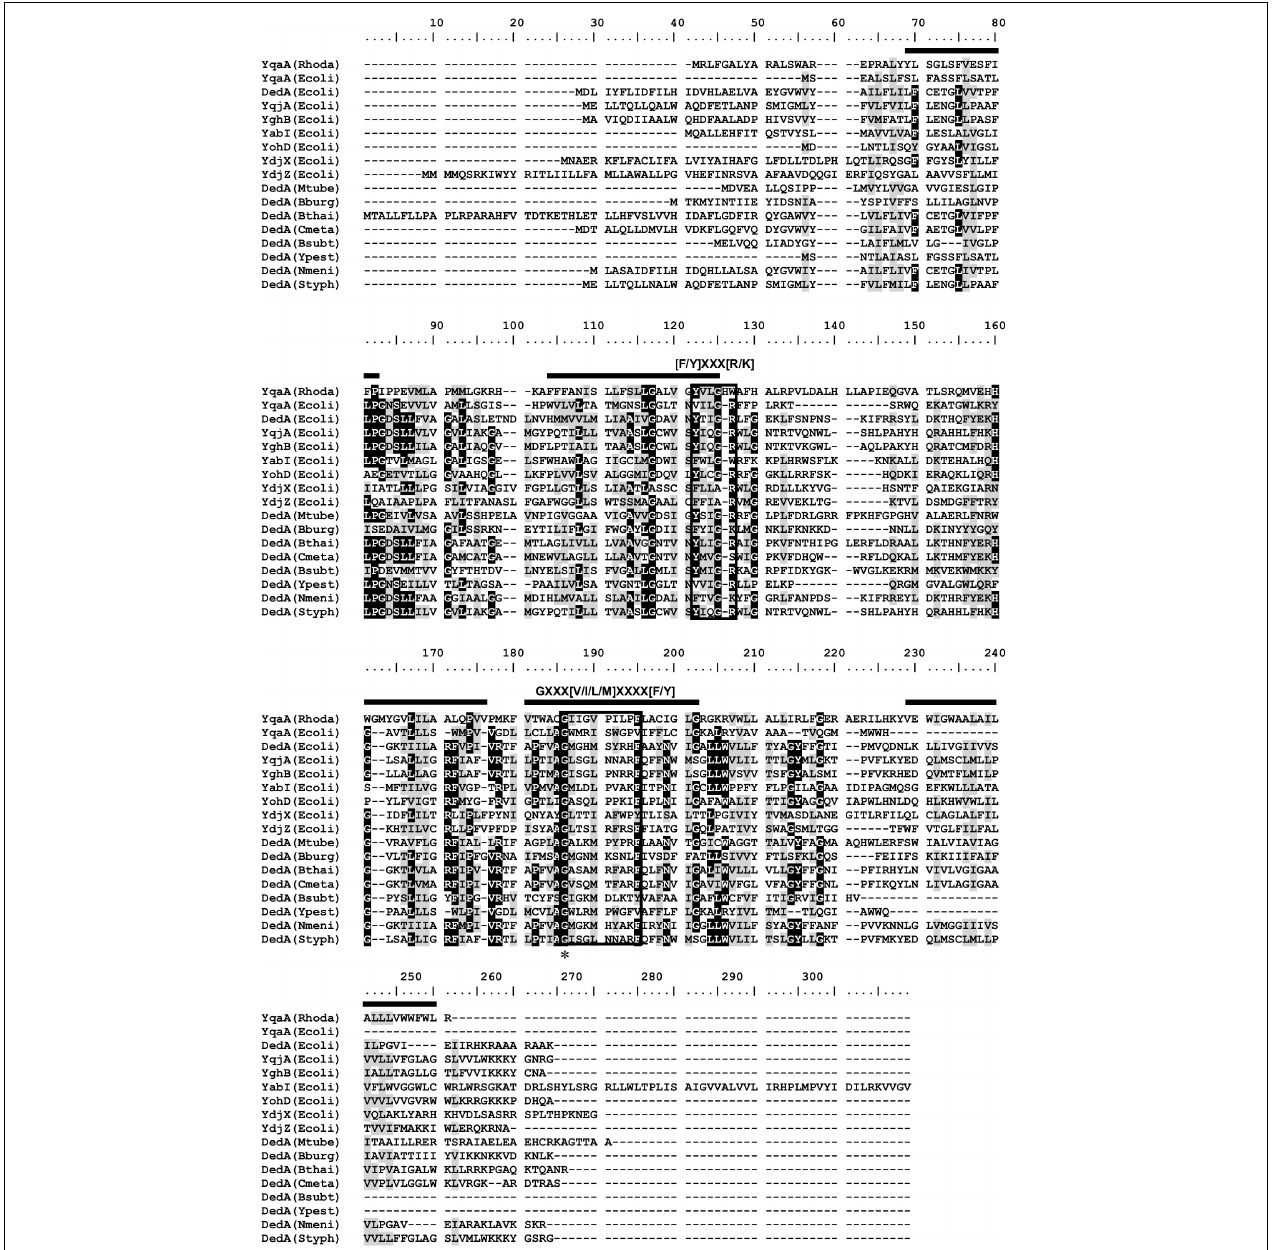
FIGURE 2 | Alignment of YqaA protein of Rhodanobacter sp. B2A1Ga4 with homolog sequences of the DedA protein family retrieved from the NCBI database. Black boxes around the sequences show the two conserved motifs previously identified in DedA protein family (Keller and Schneider, 2013; Tábara et al., 2019). Black bars represent predicted transmembrane domains for Rhodanobacter sp. B2A1Ga4 obtained by the CCTOP (Constrained Consensus Topology Prediction) software (Krogh et al., 2001; Dobson et al., 2015). Asterisk indicates the position of the glycine, the fully conserved residue in all DedA proteins. Conserved (BLOSUM62) residues were shaded according to degree of conservation: black, > 90%; gray, 50–90%. Rhodo, Rhodanobacter B2A1Ga4; Ecoli, Escherichia coli ; Mtube, Mycobacterium tuberculosis ; Bburg, Borrelia burgdorferi ; Bthai, Burkholderia thailandensis ; Cmeta, Cupriavidus metallidurans ; Bsubt, Bacillus subtilis ; Ypest, Yersinia pestis ; Nmeni, Neisseria meningitidis ; Styph, Salmonella typhimurium